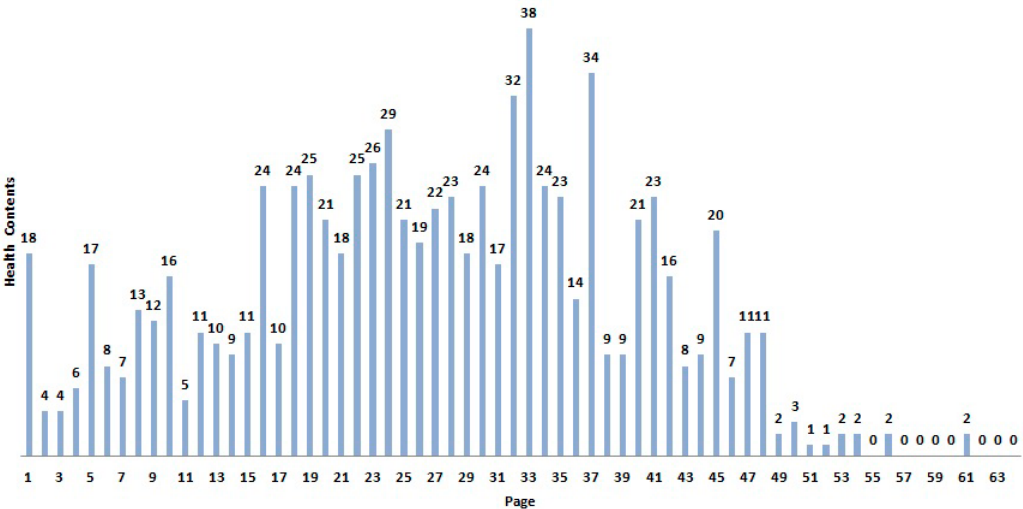
Figure 1. Amount of health content on each page.